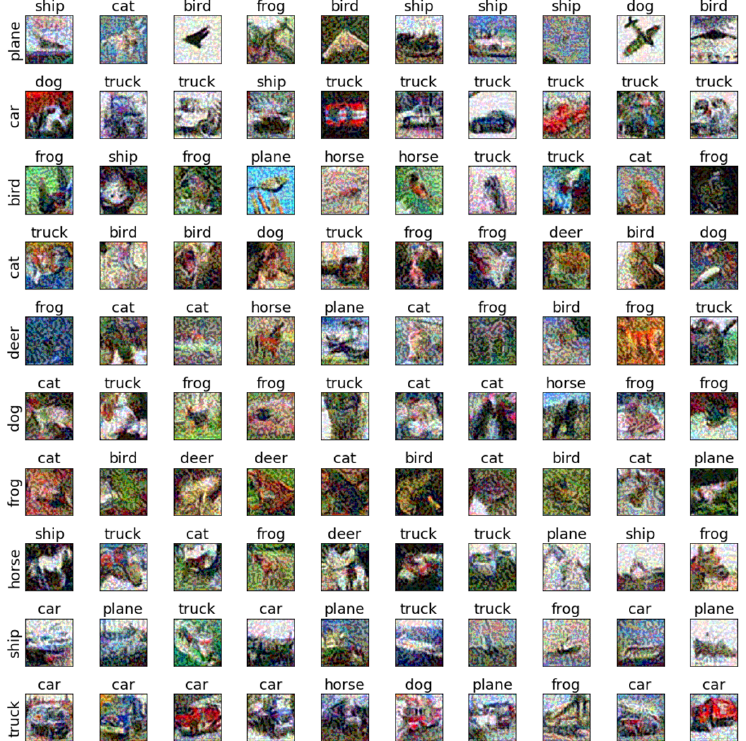
Figure 9. The adversarial examples of FGM for Cifar10 and AlexNet.